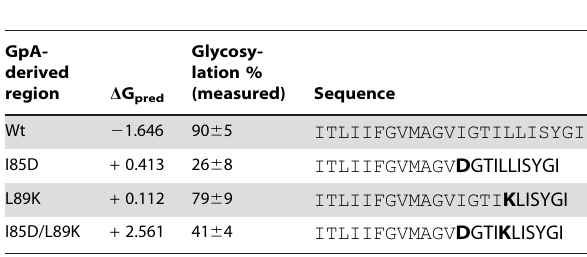
Table 1. Thermodynamic cost of GpA-derived TM segments integration.